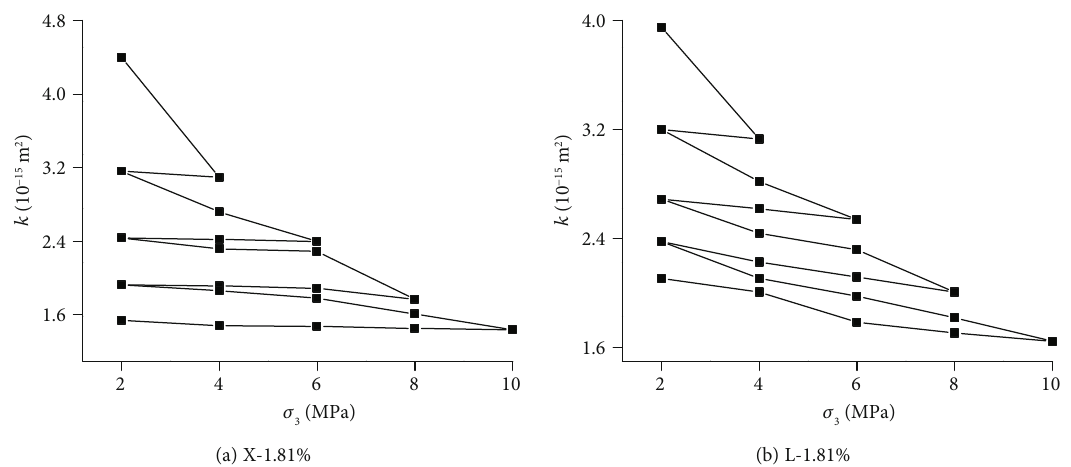
Figure 18: The permeability evolution during the loading-unloading process with the axial strain 1.81%.